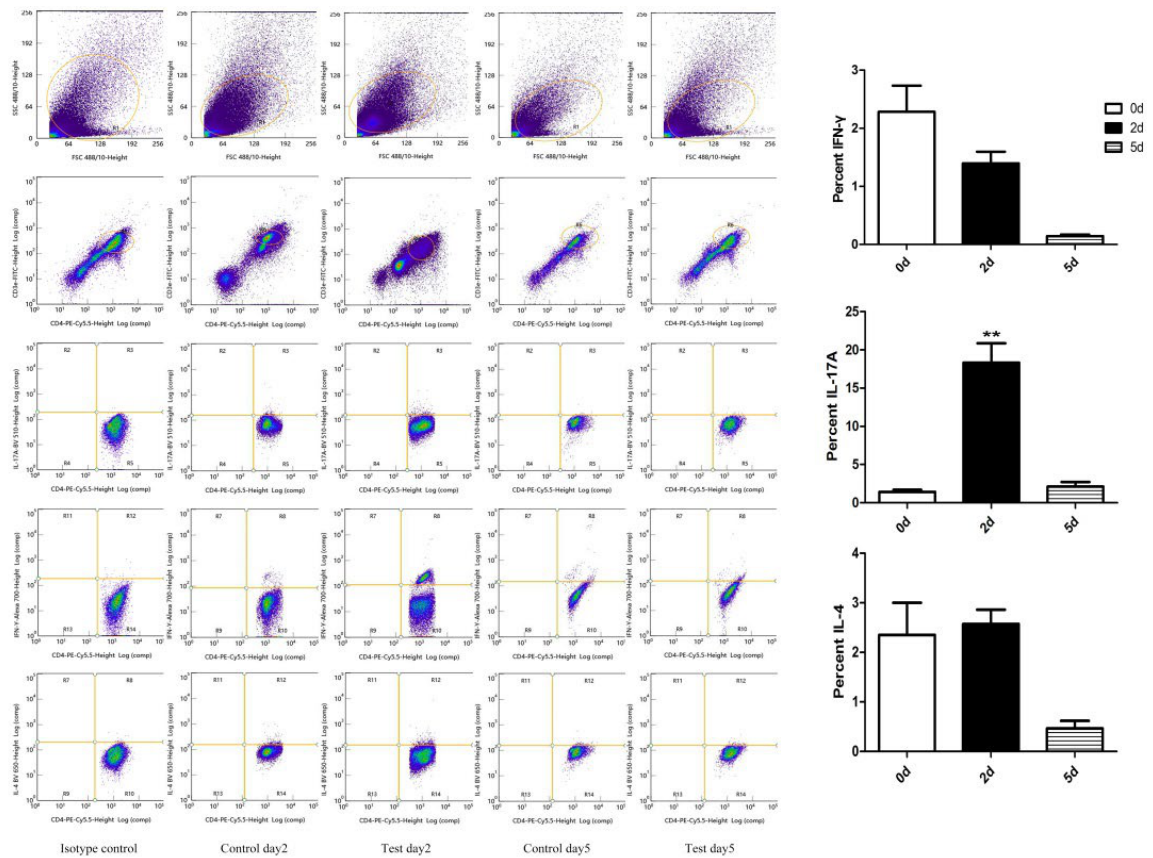
Figure 9. Th cells were recruited in the lungs of mice (n = 6) infected with M. gypseum (4 × 10 6 CFU/mL) on days 2 and 5 after infection. We detected Th cells (Th1, Th2, and Th17) with the antibodies IFN- γ , IL-4, and IL-17A, respectively. The results are presented as mean ± SD and represent three individual experiments (n = 6 mice per group). ** p < 0.01.